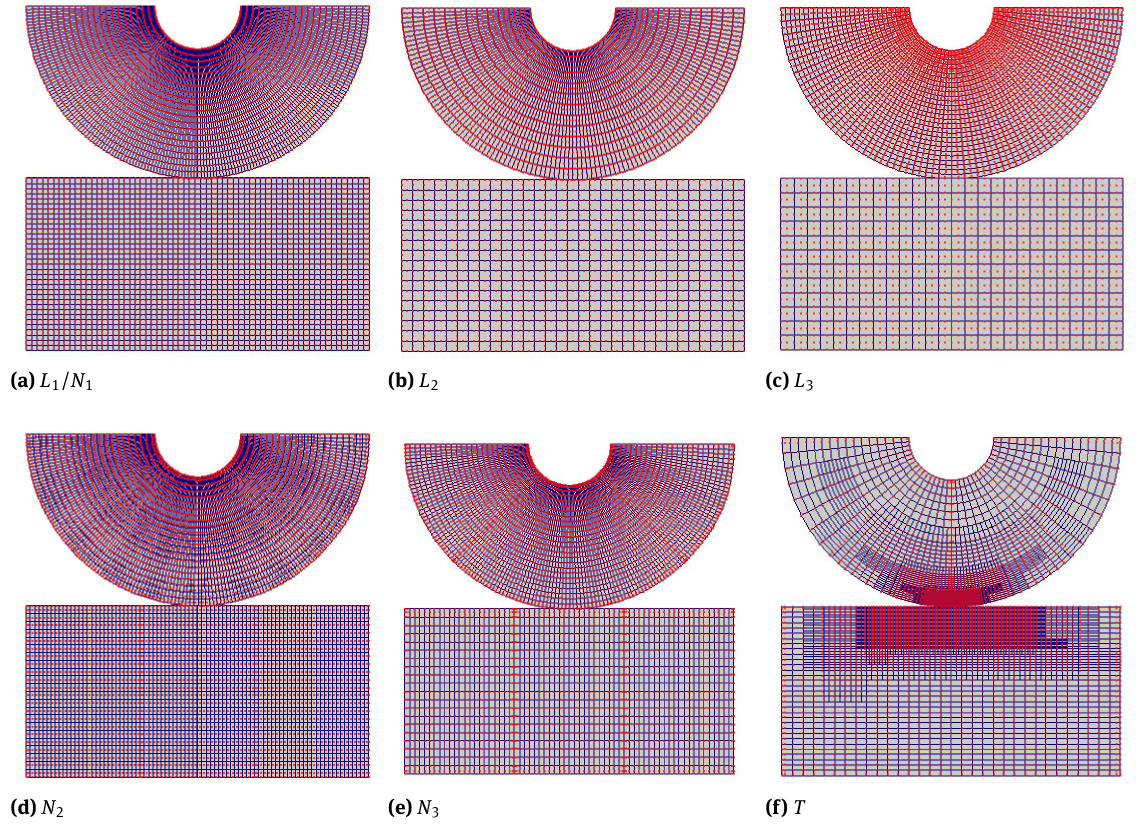
Figure 10: Ironing problem: Lagrange, NURBS, and T-spline meshes. Dof = 11904